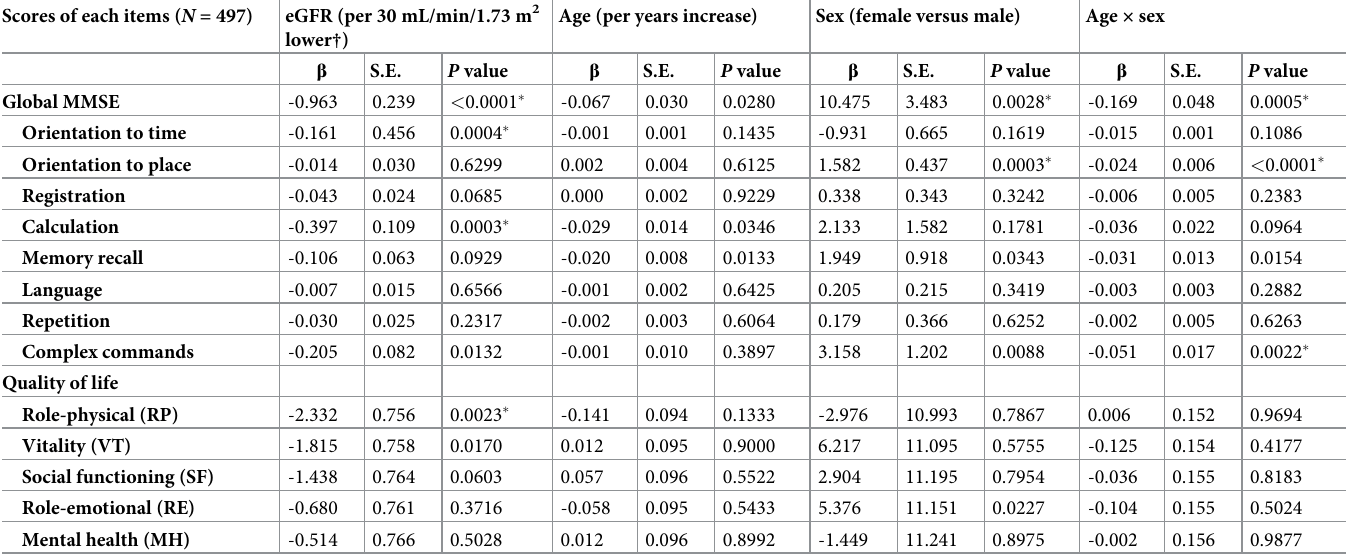
Table 3. Generalized linear mixed model estimates of Mini-Mental State examination and quality of life (adjusted by age and sex). Scores of each items ( N =